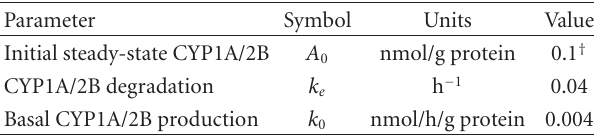
Figure 1: Schematic of a hierarchical Bayesian framework (adapted from [19]). Table 3: Basal CYP1A/2B parameters [17].